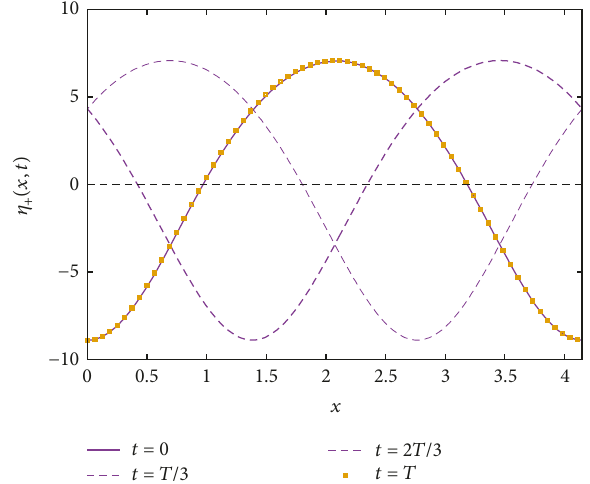
Figure 14: Time evolution of the superposition solution 𝜂 + (𝑥, 𝑡) for 𝛼 = 𝛽 = 0.3 and 𝑚 = 0.05 obtained in numerical simulations. Profiles of the wave at 𝑡 = 0, 𝑇/3, 2𝑇/3, 𝑇 are shown, where 𝑇 is the period. The 𝑥 interval is equal to the wavelength.